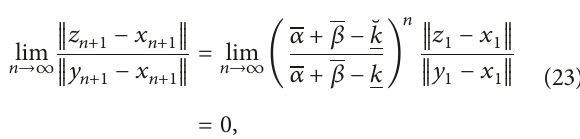
By using the similar proof method of Theorem 2 with 𝑘 𝑖 = 0 and |𝑟(1 − (𝑥